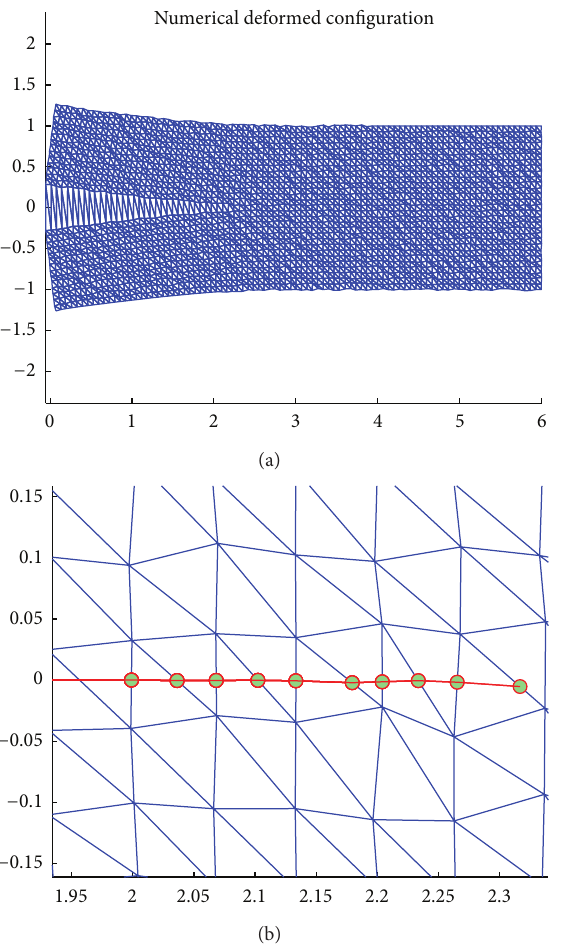
Figure 26: (a) Deformed shape of the double cantilever beam (unstructured mesh) and (b) Crack path simulated by ES-Phantom node method (unstructured mesh) after ten-step growing in which the filled circles are the new crack tip after each step.